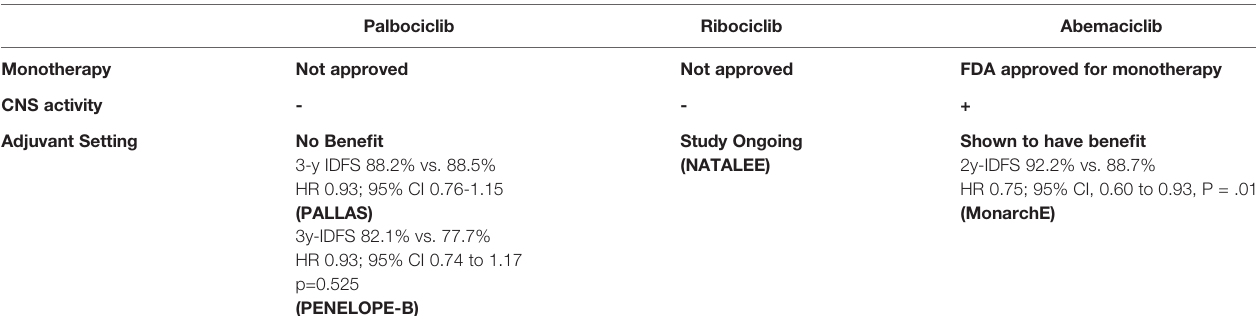
TABLE 2 | Clinical Activity of the CDK4/6 inhibitors in different clinical